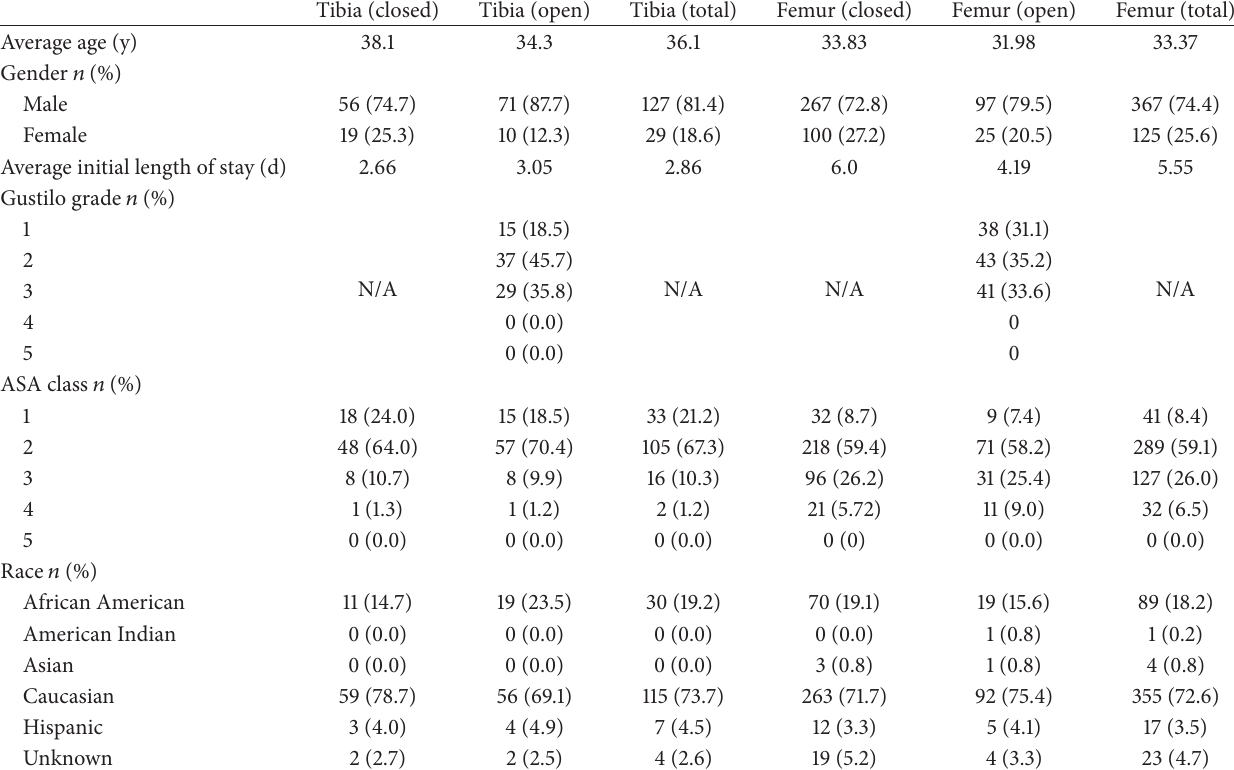
Table 1: Demographic information for patients with tibia and femur